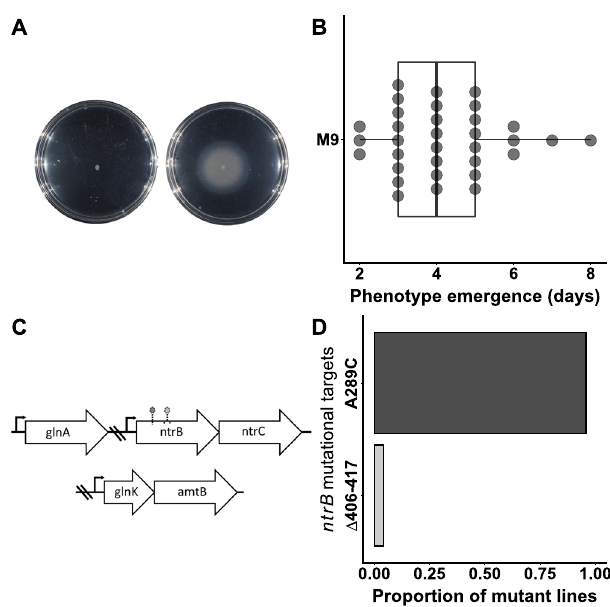
Fig. 1 Immotile variants of P. fl uorescens SBW25 (AR2) undergo highly repeatable evolution of fl agella-mediated motility. A Immotile populations evolved on soft agar (left) re-evolved fl agella-mediated motility through one-step de novo mutation (right). B Phenotype emergence on M9 minimal media appeared rapidly, typically within 3-5 days following inoculation (sample size N = 33 independent biological replicates). The centre displays the median, box bounds represent the 25 th and 75 th percentiles, and whiskers extend from the box bounds to the minima and maxima values, the lengths of which reach up to 1.5 * the inter-quartile range. Individual data points are also plotted. C The underlying genetic changes were highly parallel, with all independent lines targeting one of two sites (left circle, A289C and right circle Δ 406-417) within the ntrB locus at the expense of other sites within the nitrogen (ntr) pathway. D A single transversion mutation, A289C, was the most common mutational route, appearing in over 95% of independent lines ( N = 23/24). Source data are provided as a Source Data fi